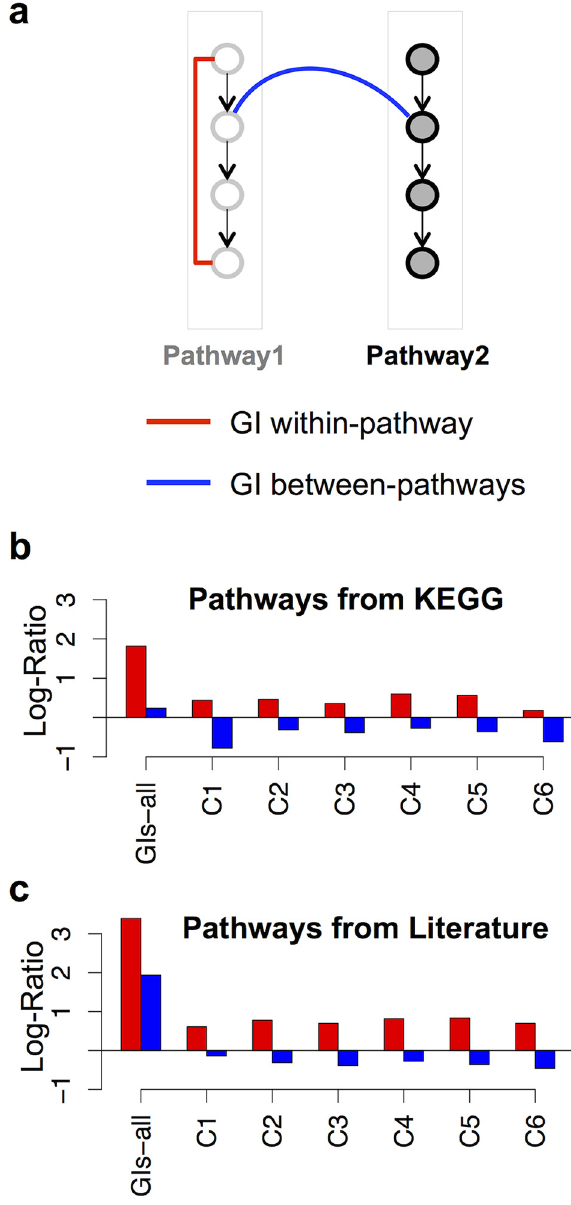
pathways 1 or 2. A red line indicates a within-pathway GI and a blue line, a between-pathway GI. (b-c) Log- Ratio scores for within-pathway (red bars) and between-pathway (blue bars) relationships observed between genes interacting through different GI classes, or present in GIs-all. A positive Log-Ratio score means that the frequency of within- or between-pathways GIs occurring in the GI class is significantly higher than the frequency of similar situations witnessed in relevant randomized GI networks with a probability of 0.99 (see